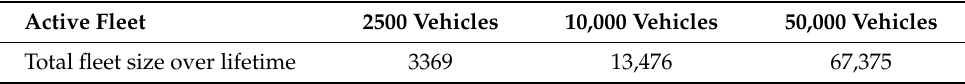
Table 1. Vehicle fleet sizes for the TCO and